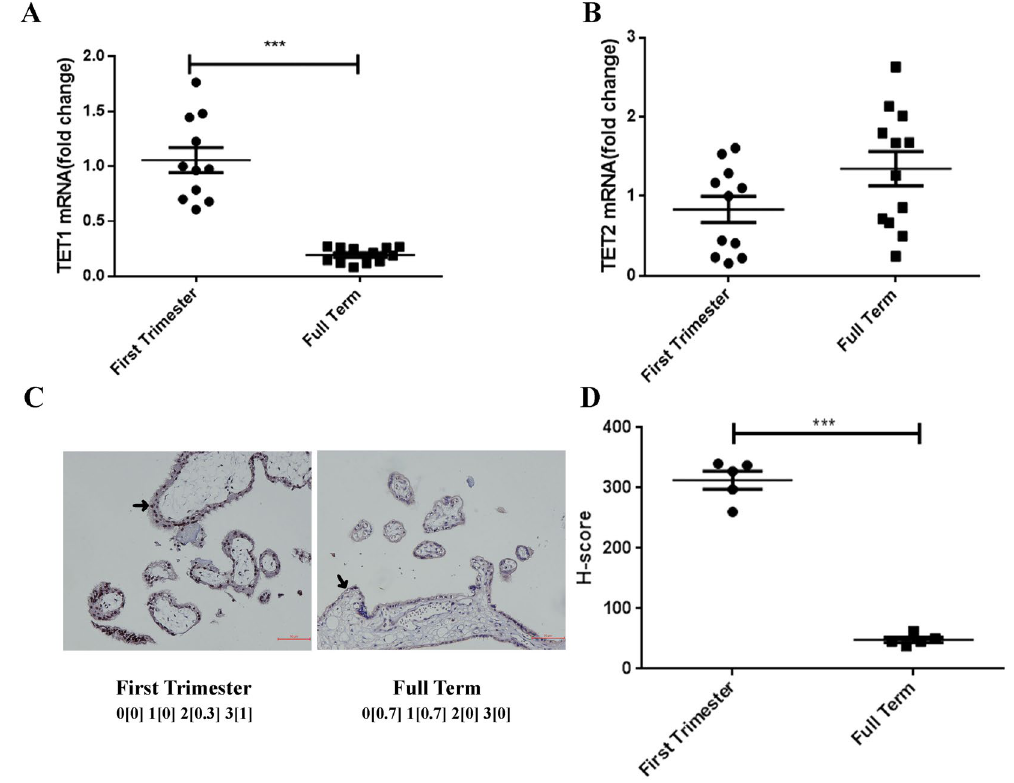
Figure-1. TET1 is highly expressed in first trimester villi. The mRNA expression of TET1 ( A ) and TET2 ( B ) in first trimester villi (7.43 ± 0.29 weeks, n = 11) and normal full term placentas (39.06 ± 0.11 weeks, n = 12) was detected by qPCR. ( *** P < 0.001, Student’s t-test) ( C ) The first trimester villi showed a high percentage of 2 + (15% equals 0.3) and 3 + (85% equals 1) staining, whereas the full term placentas had no (60% equals 0.7) and 1 + (40% equals 0.7) TET1 staining, as analyzed using IHC. (Asterisk, trophoblast cell) ( D ) H-score for the TET1 staining between the first trimester villi and normal full term placentas. (n = 5, *** P < 0.001, Student’s